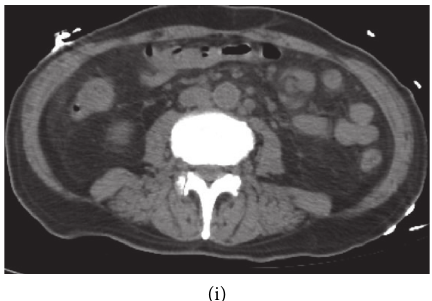
Figure 1: Autopsy findings and figures. (a) The normal lymph node architecture is replaced with granulomatous inflammation with abundant Coccidioides fungal organisms (hematoxylin and eosin stain 20X magnification. (b) Lymph node: Grocott-Gomori’s methe- namine silver stain (GMS) highlights Coccidioides organisms at 20X magnification. Note empty spherules and spherules filled with endospores. (c) Lung alveolar spaces are filled with caseating granulomatous inflammation with abundant Coccidioides spherules with and without endospores (hematoxylin and eosin stain 20X magnification). (d) Lung: GMS stain highlights Coccidioides spherules in the lung tissue. (e) Left lung: innumerable diffuse tan nodules show miliary spread in the upper and lower lung lobes with predominance in the upper lobes in the lungs. The lungs were grossly boggy and congested; the left lung weighed 1250 grams (mean 400 grams). (f) Right lung: innumerable diffuse tan nodules showing miliary spread in the upper and lower lung lobes with predominance in the upper lobes in the lungs. The lungs were grossly boggy and congested; the right lung weighed 1400 grams (mean 450 grams). (g) Lymph nodes are diffusely enlarged and display a homogenous cut white/tan surface. (h) Axial plane view of the CT scan of the lungs showing military pattern of distribution of innumerable centrilobular and paraseptal pulmonary nodules in a random/miliary pattern of disease. (i) Axial plane of the CT scan of the abdomen and pelvis showing multiple enlarged lymph nodes along the periaortic distribution, right external iliac, and internal iliac